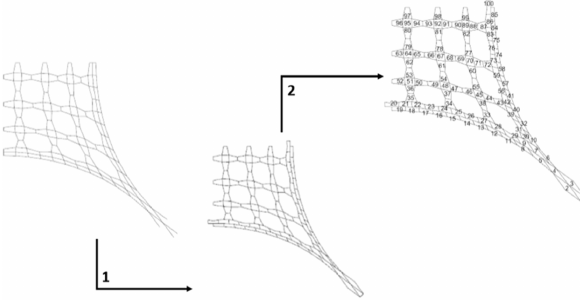
Figure 8: 3D Geometrical Model of the scaled prototype – Perspec- tive View